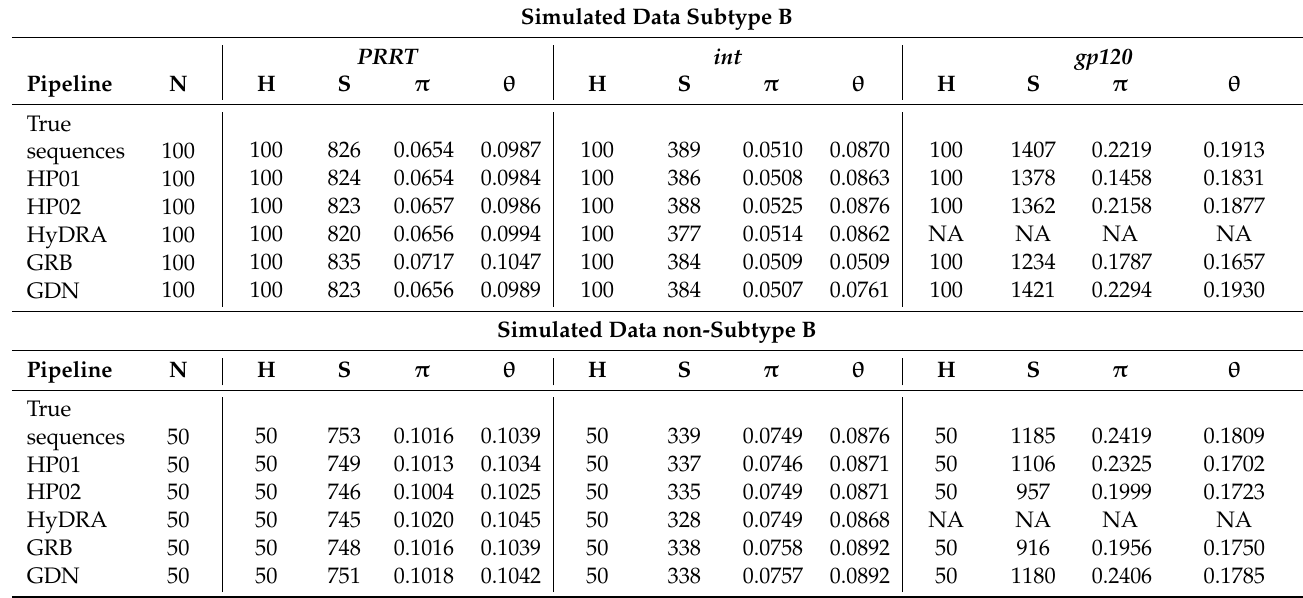
Table A5. Comparison of the e ff ect of consensus generation on estimated genetic diversity across the simulation